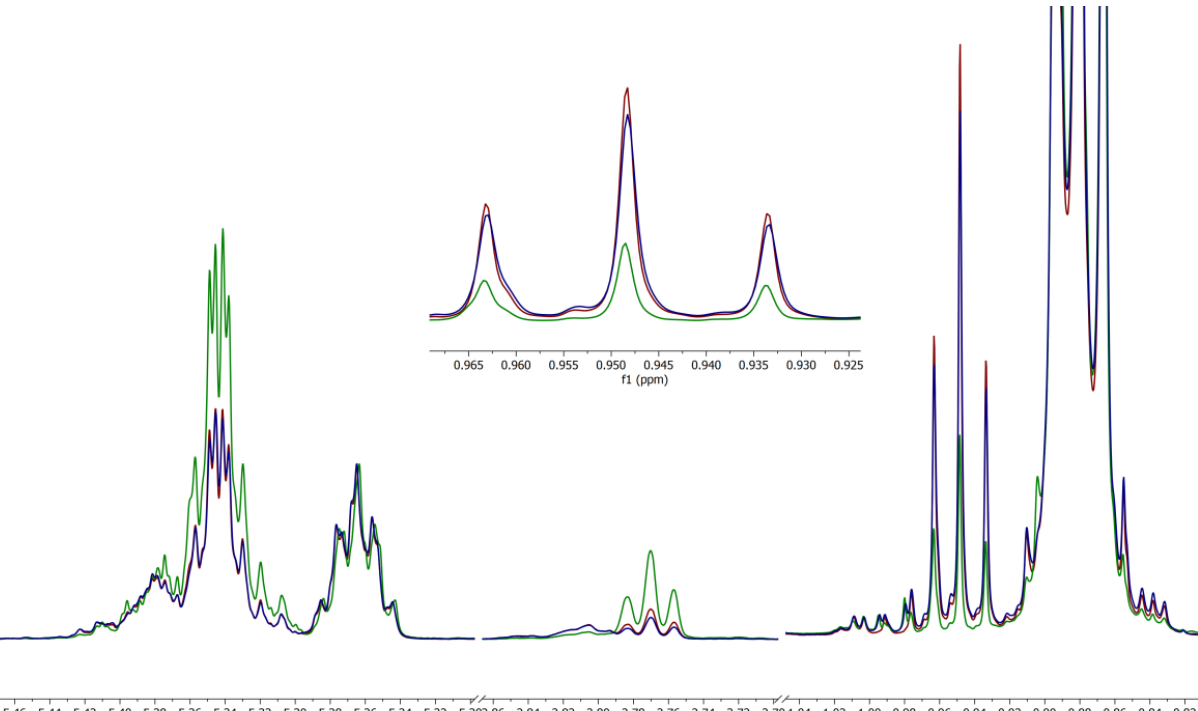
Figure 6. 1 H 500 MHz NMR spectral excerpt of samples 3 (green), 42 (blue), and B1 (maroon). Normalized for intensity to the glycerol peak at 5.265 ppm. Inset: Expansion of ω -3 terminal methyl region included for clarity.